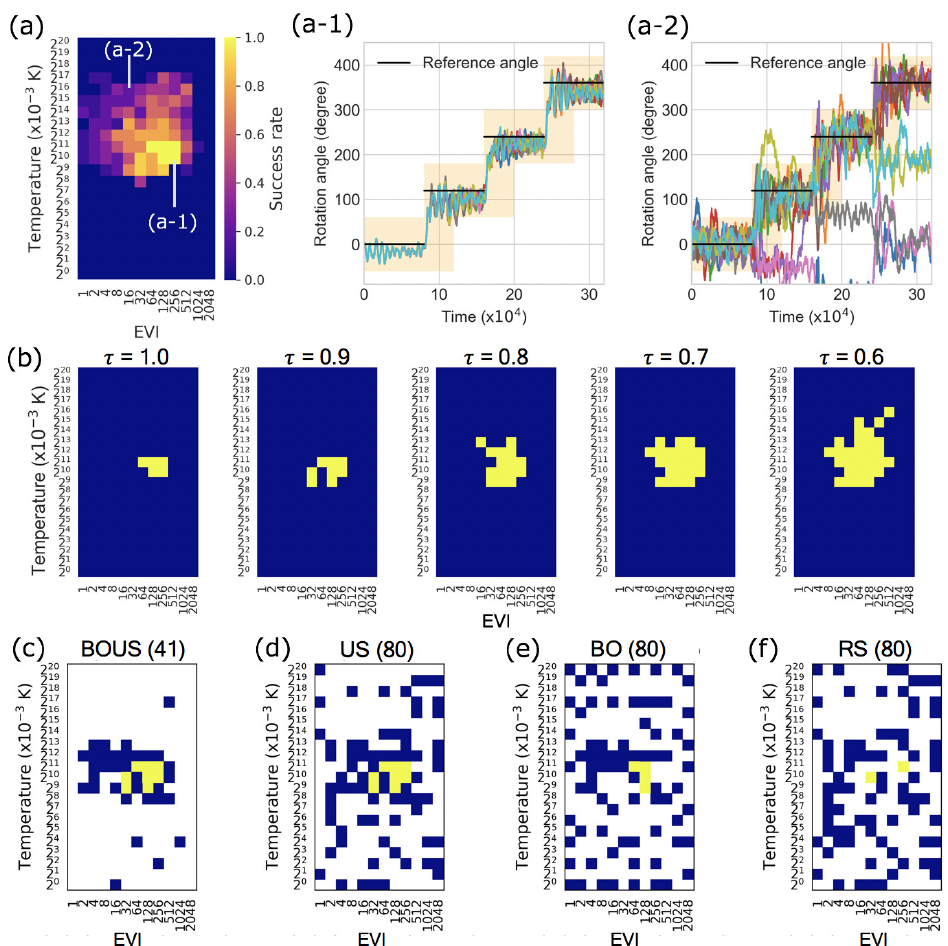
Figure 3. ( a ) Success rate distribution of F1-motor rotation based on Newtonian dynamics simulations in the parameter space. (a-1) and (a-2) show examples trajectories of F1-motor rotations in ( a ). The success rates were 1 and 0.2, respectively. ( b ) Regions of successful parameters changing the criteria (success threshold τ ) to ensure success. The yellow and blue grids are “success” and “failure” parameters in each threshold τ , respectively. ( c – f ) are typical examples of successful parameter search using BOUS, US, BO, and RS. The numbers of sampled parameters were 41 for BOUS and 80 for US, BO, and random sampling